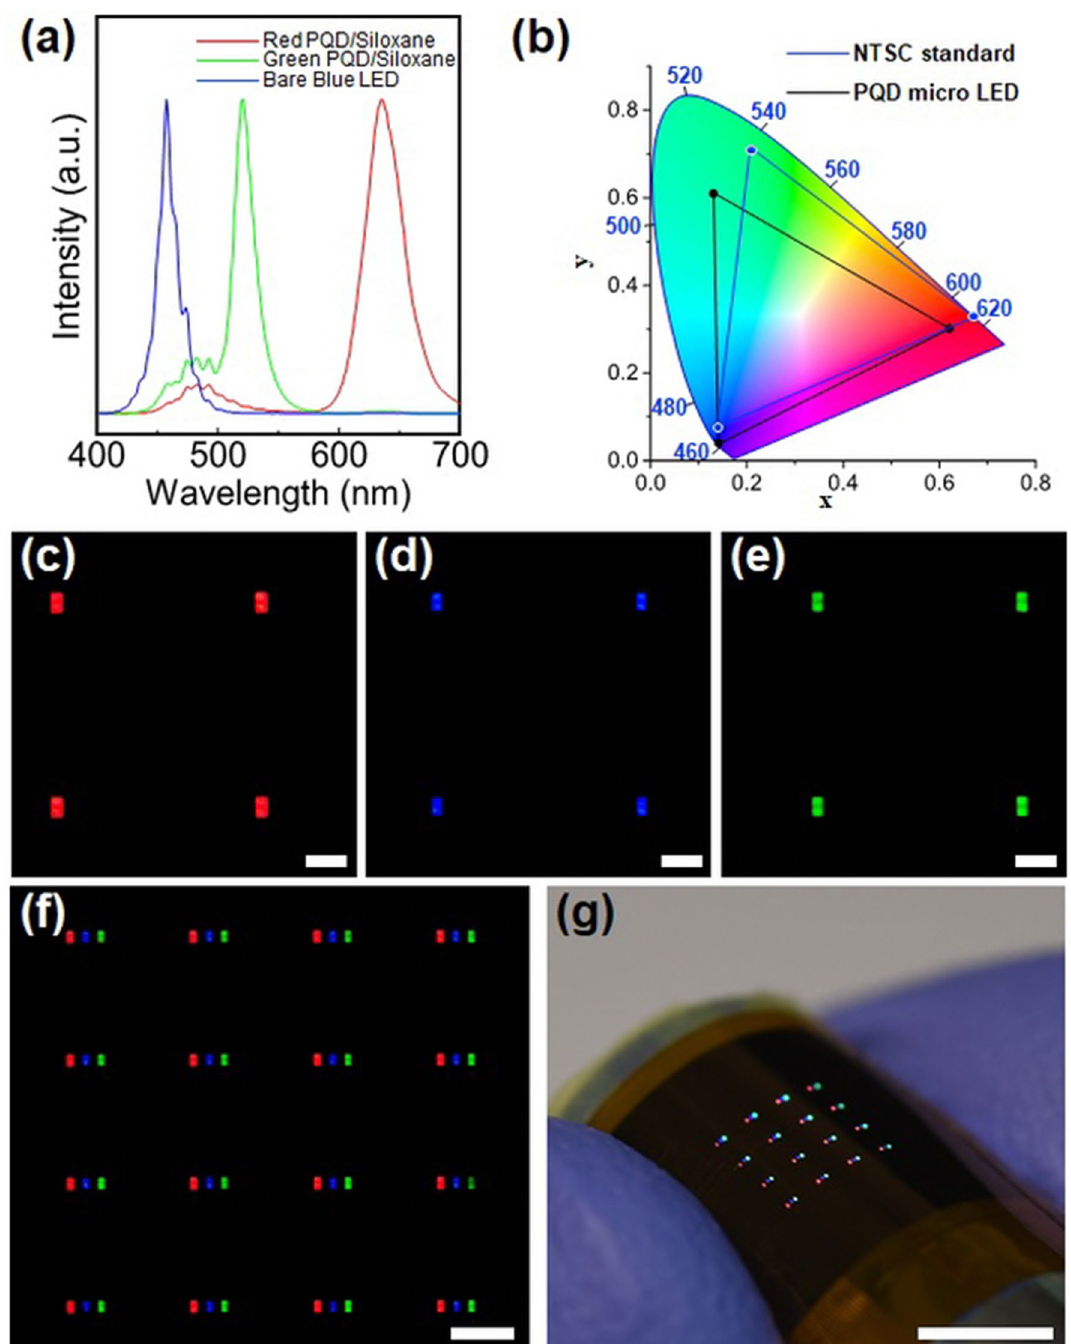
Figure 5. ( a ) Normalized photoluminescence spectra of RGB light from full-color micro-LEDs with perovskite quantum dot (PQD)/siloxane composite as color conversion layers (CCLs). ( b ) CIE color coordinates corresponding to the RGB light. The black and blue lines show the CIE color coordinates of the PQD micro- LED display and NTSC, respectively. Optical microscope images of ( c – e ) a partially enlarged individual pixel (scale bar: 200 µm) and ( f ) the whole pixels (scale bar: 500 µm) of the micro-LED with PQD/siloxane composite as CCLs. ( g ) Image of the full-color micro-LED with PQD/siloxane composite as CCLs under bending (scale bar: 5